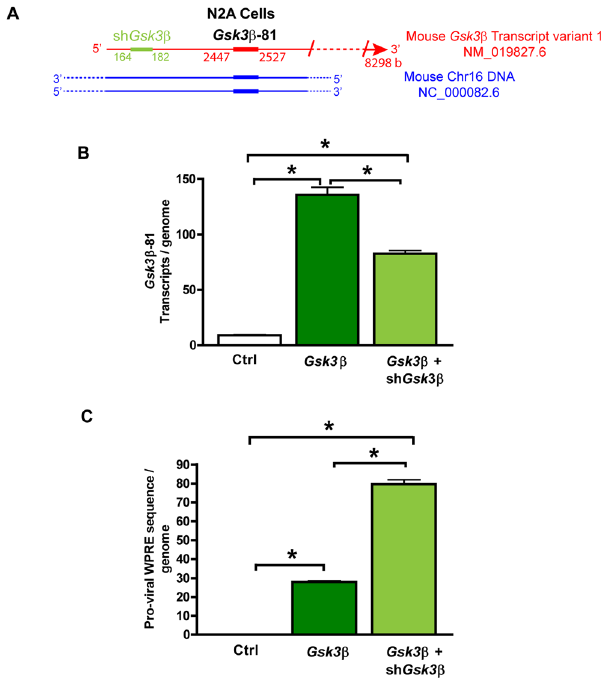
Figure 5. Absolute measurement of RNA interference by digital Selfie-dPCR. To obtain an absolute value of gene silencing by RNA interference, lentiviral-mediated overexpression of Gsk3 β was silenced by co- transduction of a short hairpin Gsk3 β for RNA interference (sh Gsk3 β ) in an N2a neuroblastoma cell line. ( A ) Schematic diagram showing the positions of the sequence targeted by sh Gsk3 β (in green) and the Gsk3 β -81 amplicon. ( B ) Quantification of Gsk3 β transcripts per genome after lentiviral-mediated Gsk3 β transgene overexpression and silencing. ( C ) Number of proviruses integrated per genome, as assessed by the number of WPRE